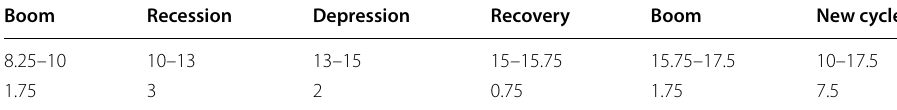
Table 11 Duration of phases of the two adjacent growth cycles (years) in L-1 Boom Recession